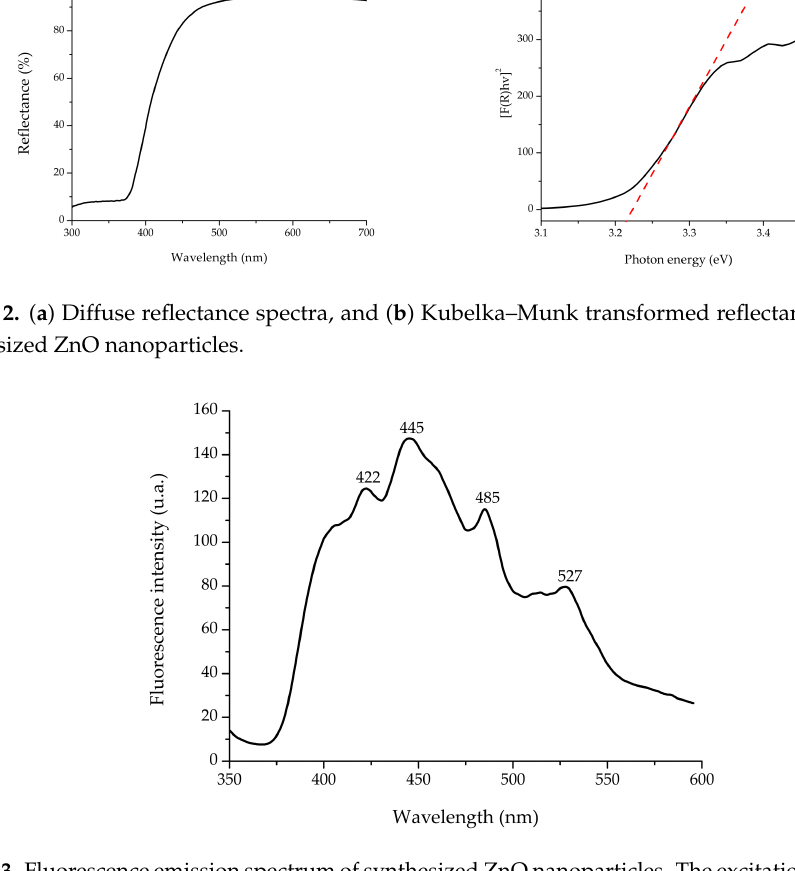
Figure 3. Fluorescence emission spectrum of synthesized ZnO nanoparticles. The excitation wavelength was 325 nm.